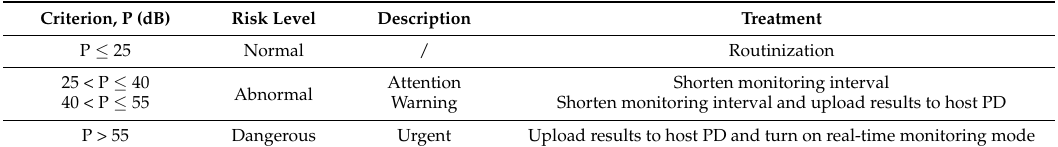
Table 3. Risk determination via quantity analysis.